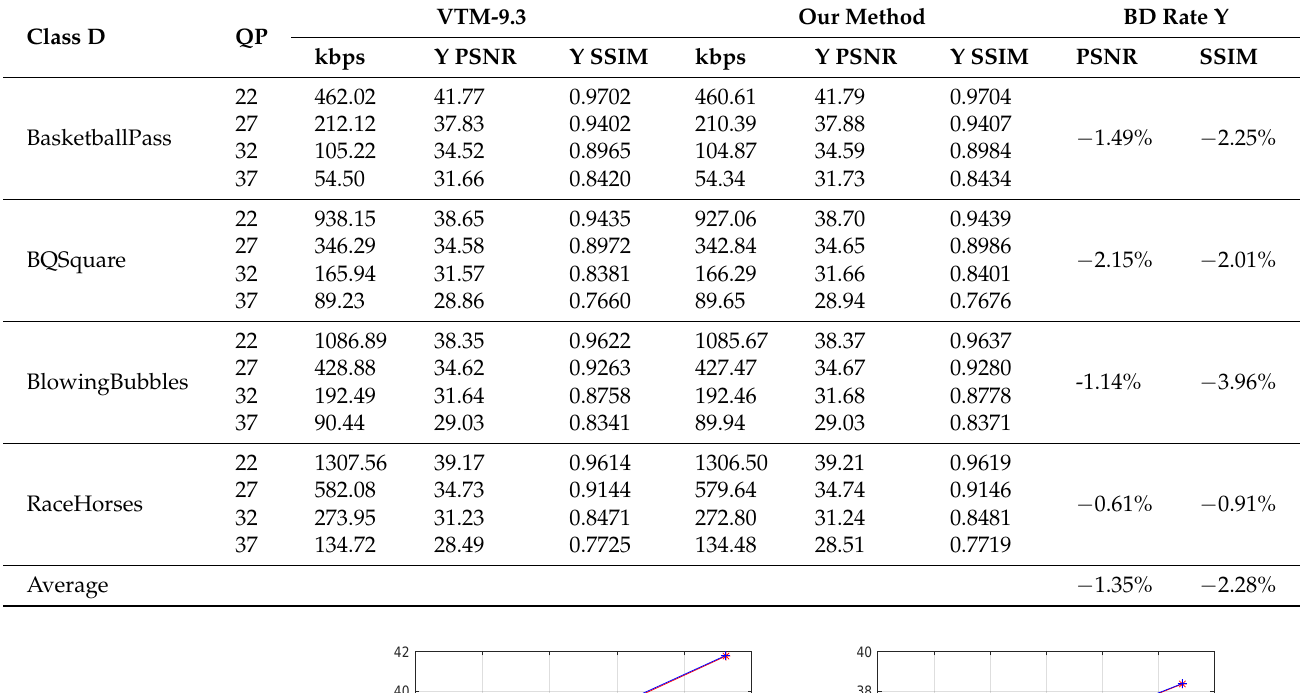
Table 1. Results of Our RBENN Compared to VTM9.3 under LDP.